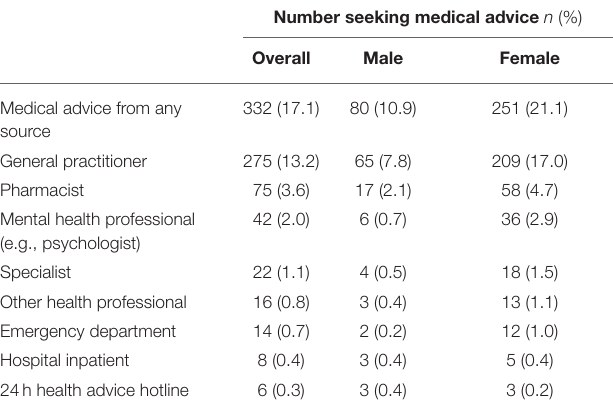
TABLE 7 | Proportion of surveyed ACT region residents that sought medical advice in relation to bushfire smoke attributed health conditions during the 2019–20 bushfire